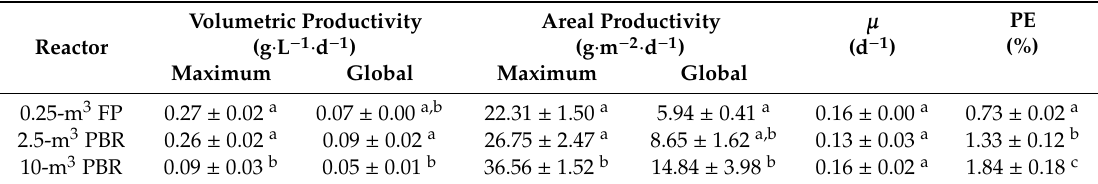
Table 1. Maximum volumetric productivity, overall volumetric productivity, maximum areal productivity and overall areal productivity, specific growth rate ( µ ) and photosynthetic e ffi ciency (PE) of pilot- and industrial-scale tubular photobioreactors (PBR). Di ff erent letters indicate significant di ff erences between reactors. Values are given as means ± standard deviation ( n =